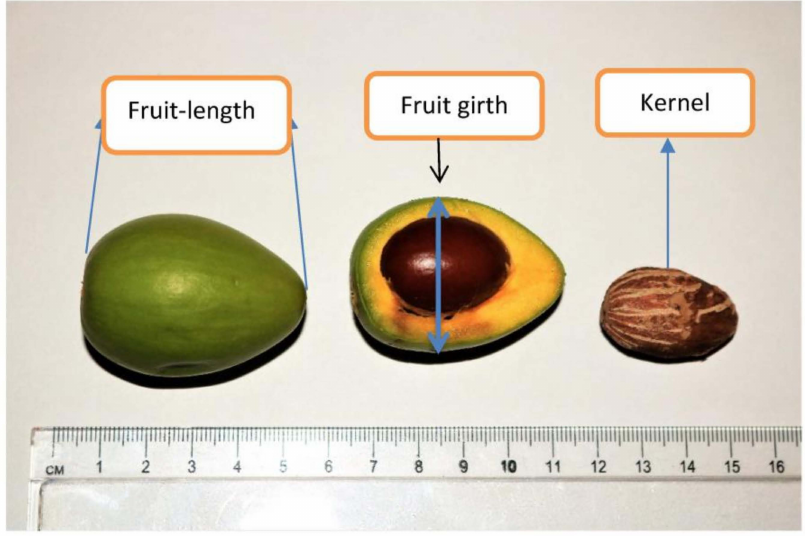
Figure 2. Cross section of shea fruits.